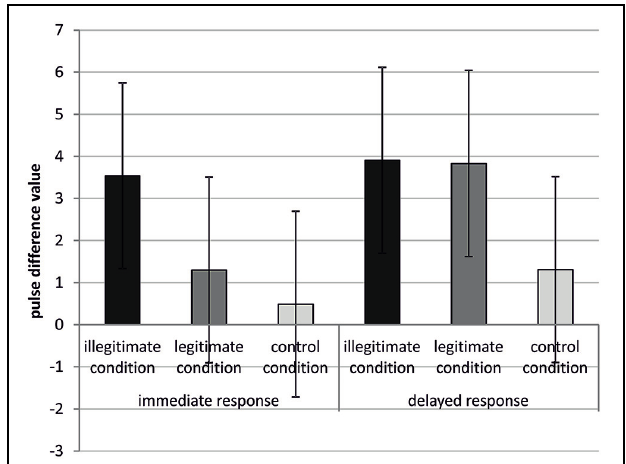
FIGURE 2 | Physiological arousal for the immediate and delayed response in the three experimental groups.